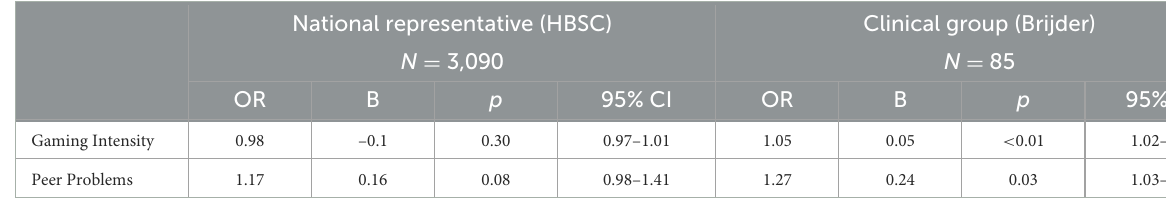
TABLE 6 Multinominal regression analyses with subsample as grouping variable, and gaming and peer problems as predictors for boys only. National representative